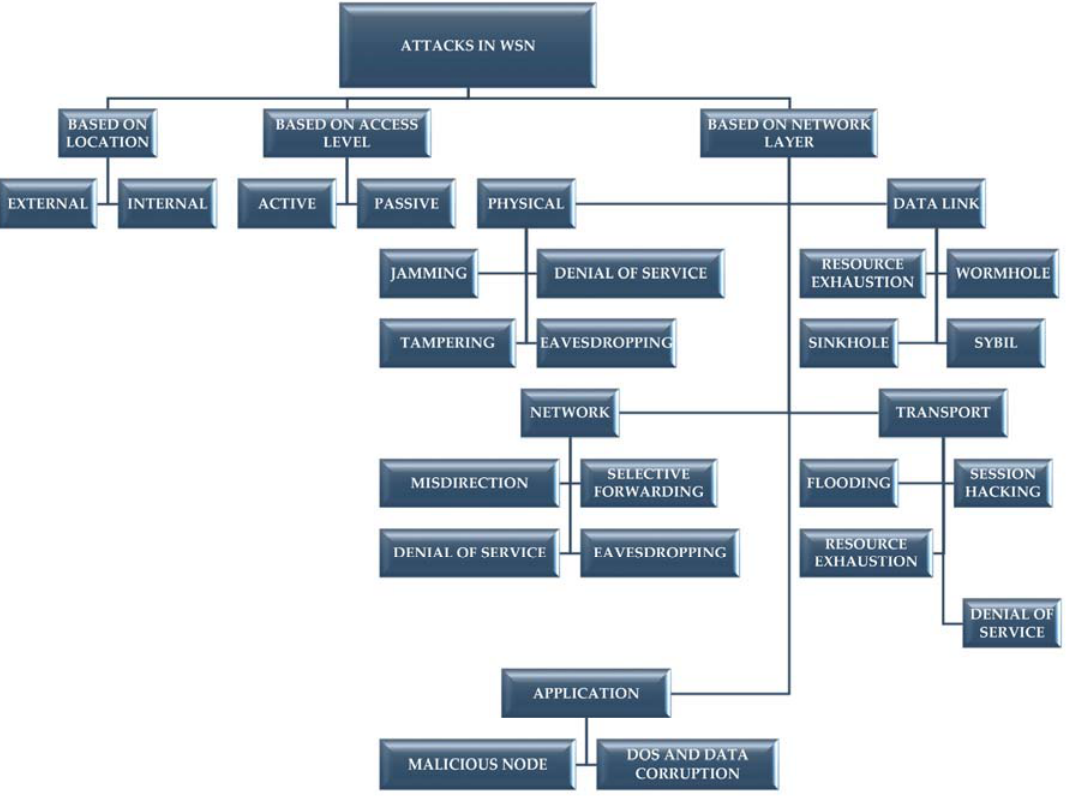
Figure 5. Classification of various attacks in